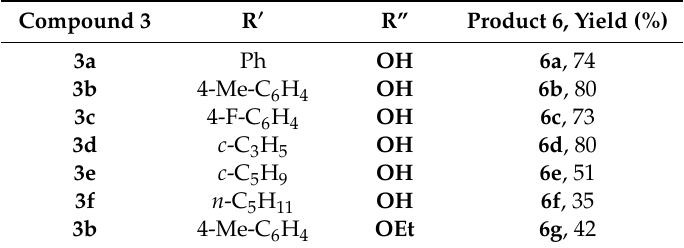
Table 2. Isolated yields of compounds 6a – g.